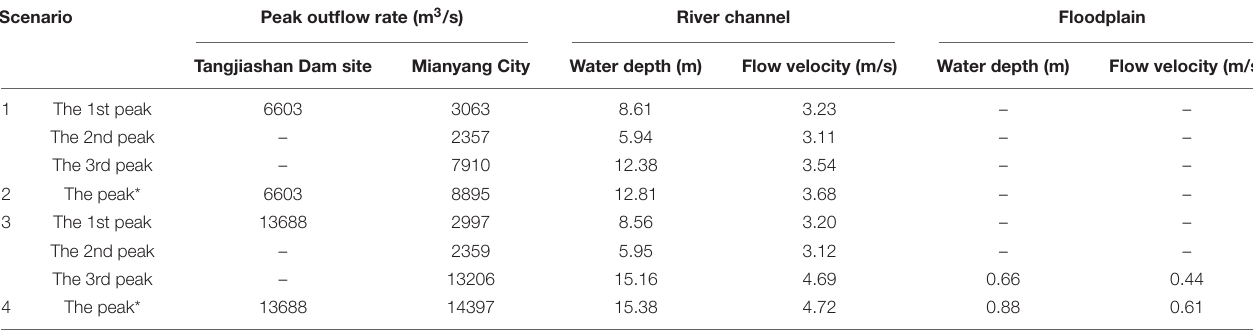
TABLE 4 | Hydraulic parameters of cascading breach in the four scenarios in Mianyang City. Scenario